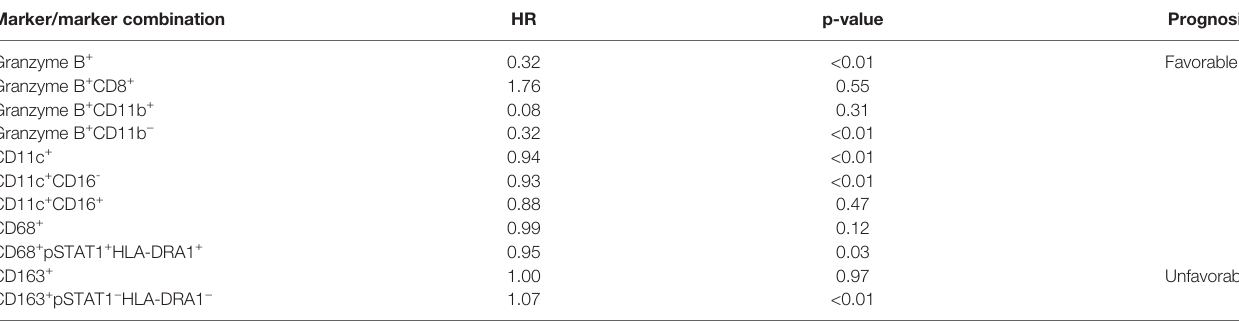
TABLE 2 | Selected immune cell classes and their survival effects (continuous cell classes). Marker/marker